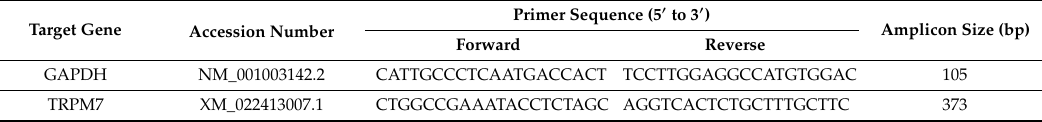
Table 1. Specific oligonucleotide primer sequences used for reverse transcription-polymerase chain reaction with amplicon sizes in this